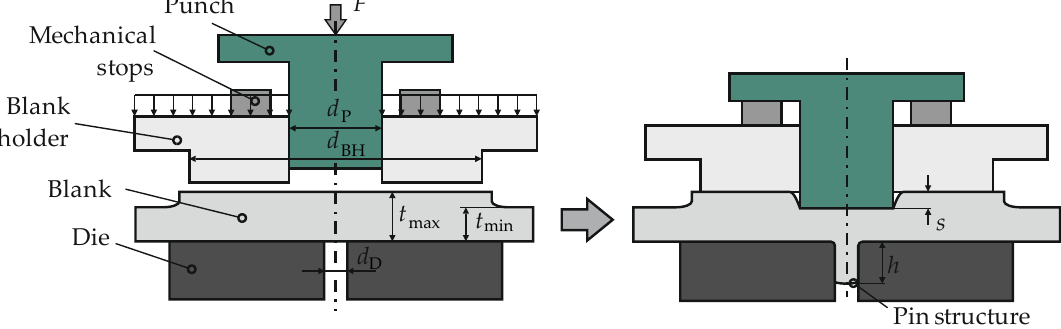
Figure 2. Schematic illustration of the pin extrusion process with local material pre-distribution.